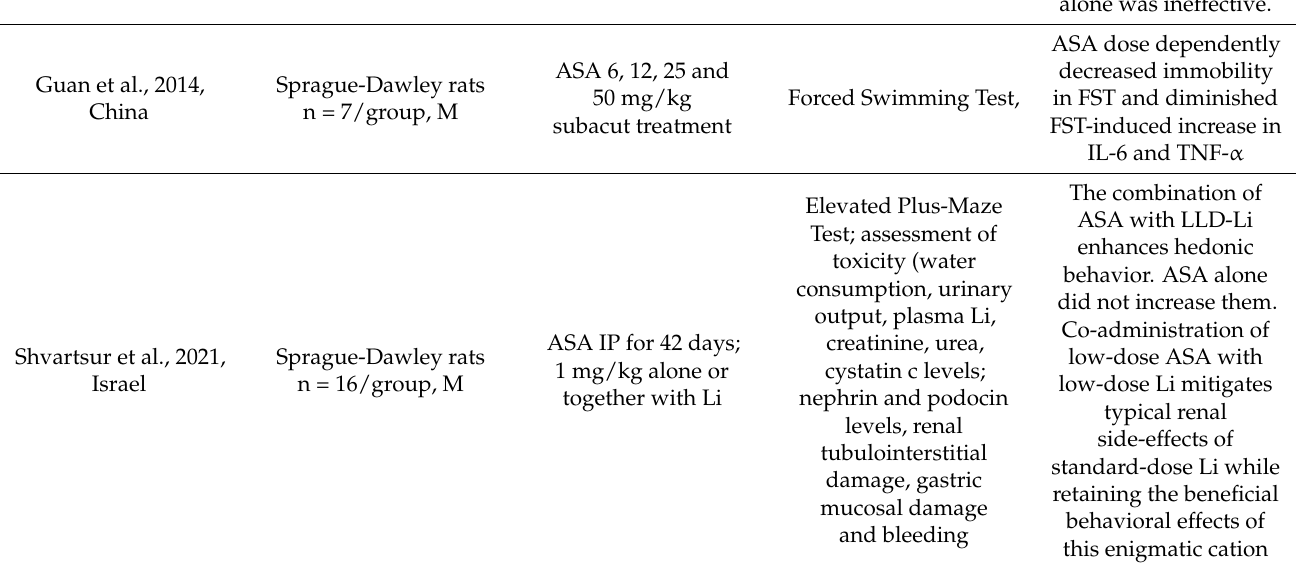
Table 2. In Vivo Studies on ASA in Animal Models of Depression or Mania.